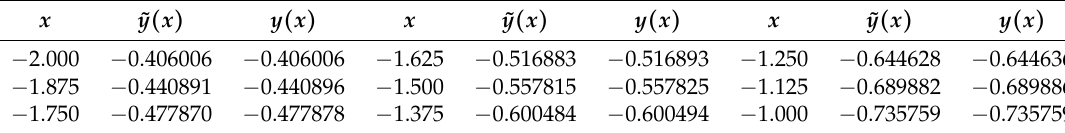
Table 1. Comparison of the numerical solutions with the exact solutions in Example 1 ( h = 2 − 3 ) .